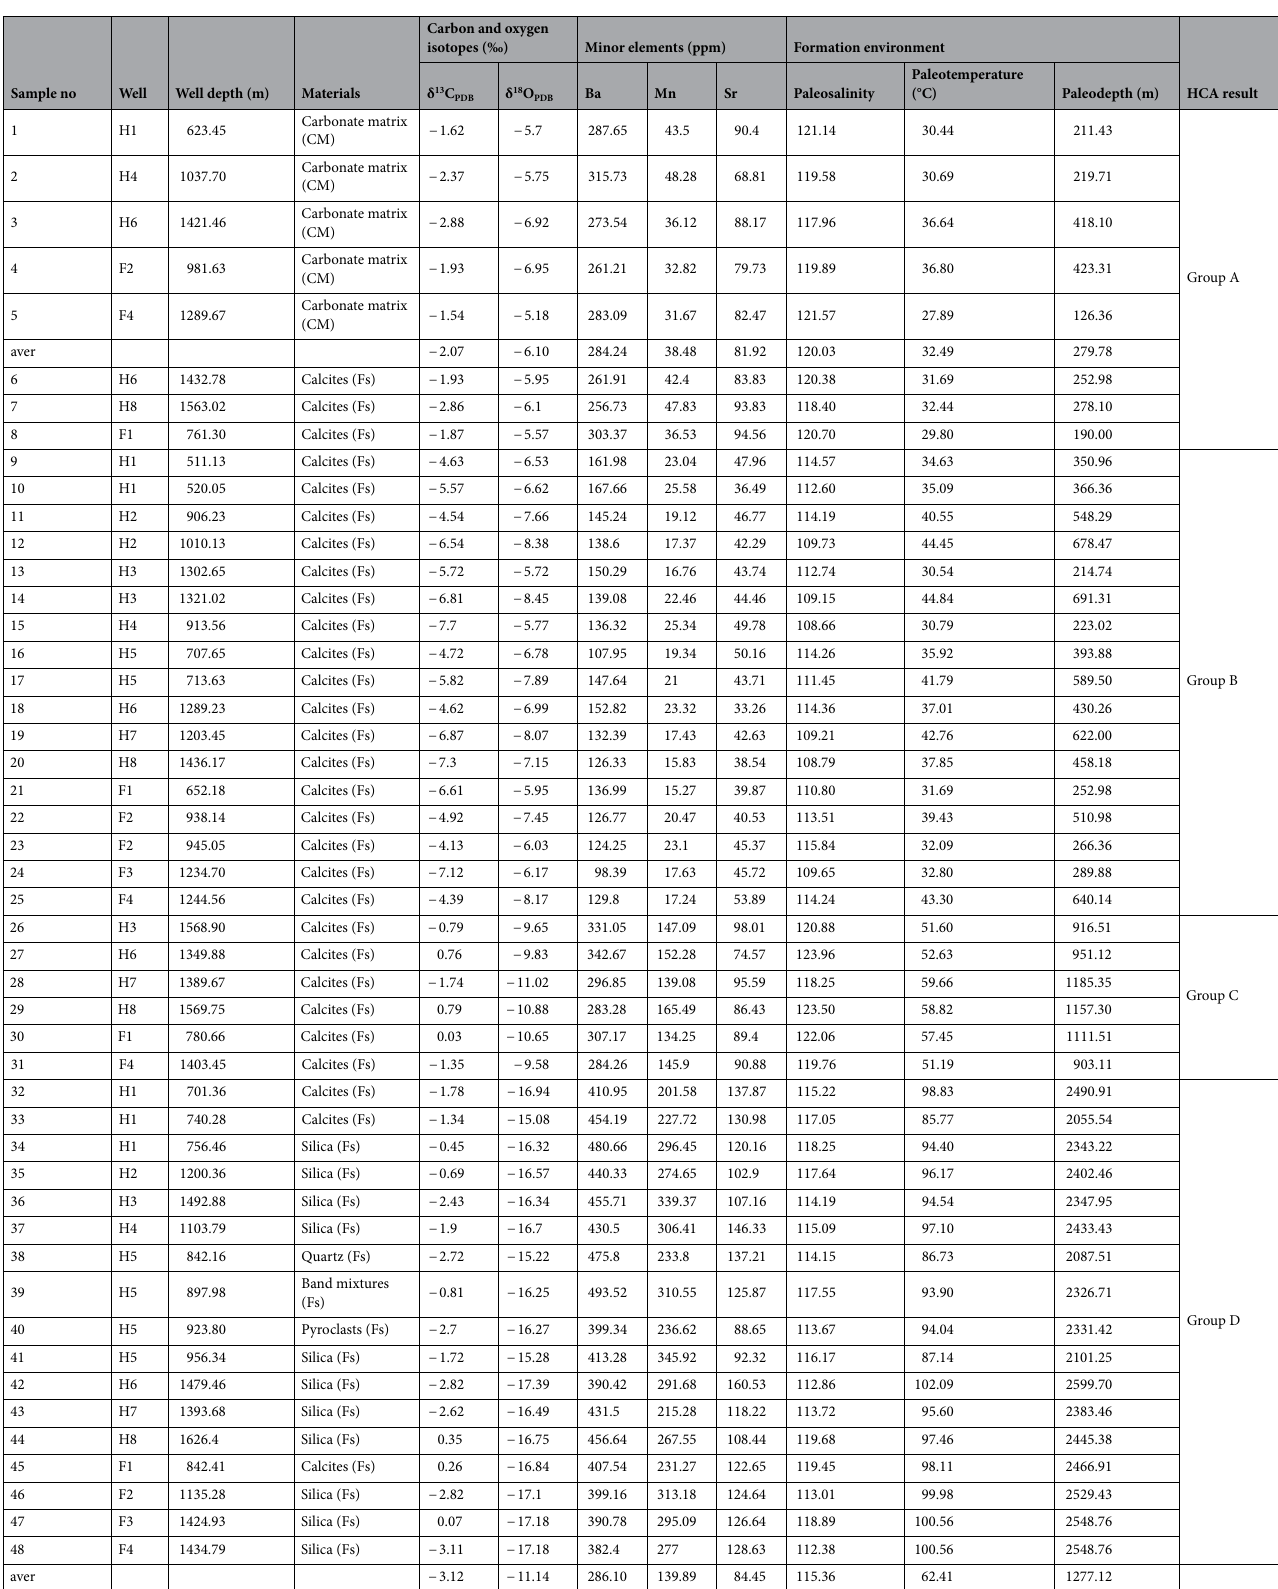
Table 1. Geochemical results for the Ordovician carbonate matrix (CM) and fillings